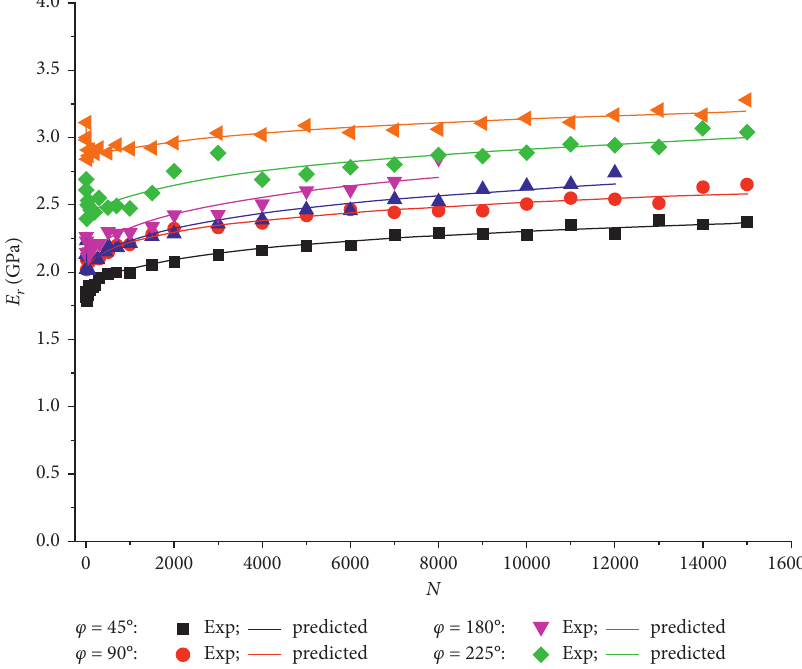
Figure 6: Relationship between resilient modulus and the number of load cycles with a different phase difference of principal